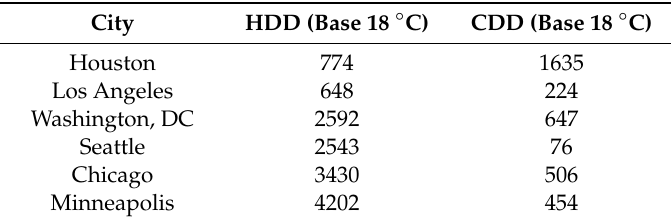
Table A1. HDD and CDD for di ff erent climate locations.